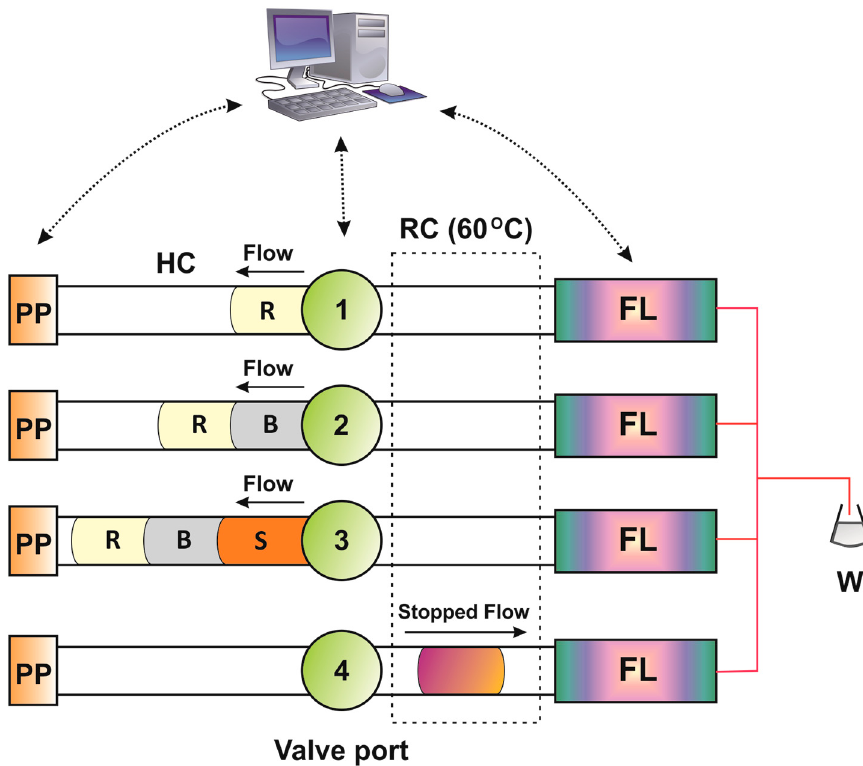
Figure 3. ZF sequence for the determination of HIS: PP = peristaltic pump; R = OPA reagent (10